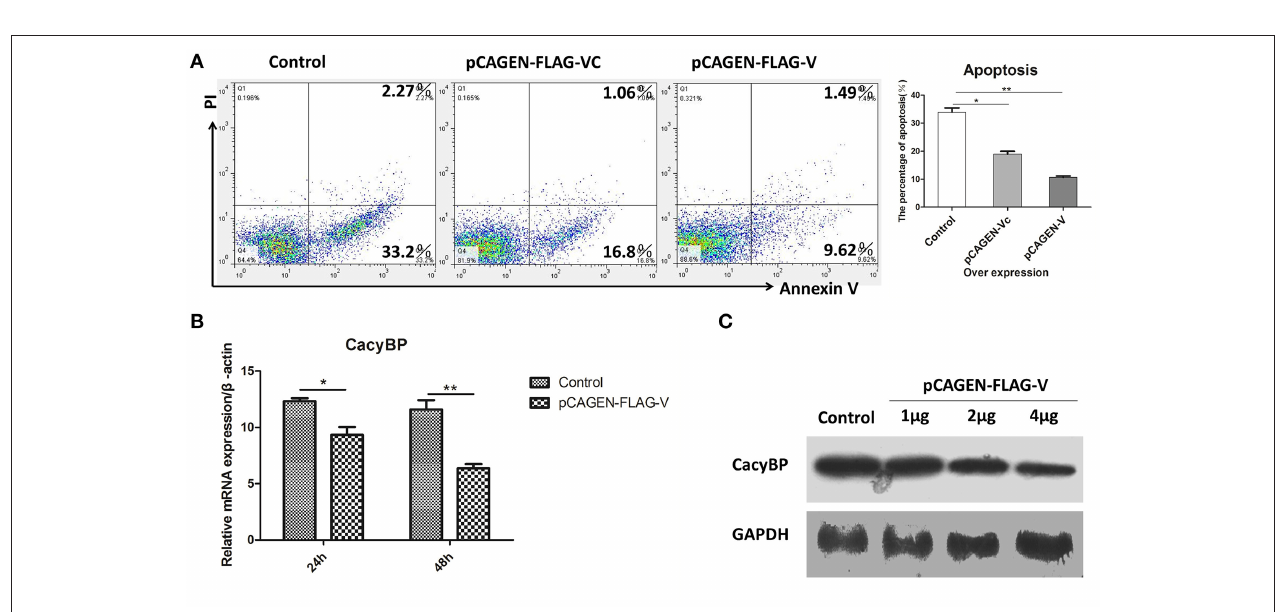
FIGURE 4 | cells 24h after transfection. Q-PCR was used to measure viral RNA replication 24 hpi. (D) Viral plaque formation tests were further used to measure the number of viruses in the supernatants. (E) Three cell cultures were prepared and transfected with mock, NC and siRNA (326), and then, the cells were washed and harvested,an annexin V assay was followed by flow cytometry to monitor for percentage of cells undergoing early apoptosis (bottom right quadrant) and late apoptosis(upper right quadrant). Y-axis is PI signal; X-asis is annexin V-FITC signal. Right graph data were the percentage of total apoptosis (bottom and upper right quadrant)and data from three independent experiments. (F–H) Q-PCR was used to analyze the expression of apoptosis-related markers and immune-associated markers 24h after transfection with NC and si-CacyBP/SIP. (G) The transfected cell lysate was analyzed by western blotting with the indicated apoptosis-related